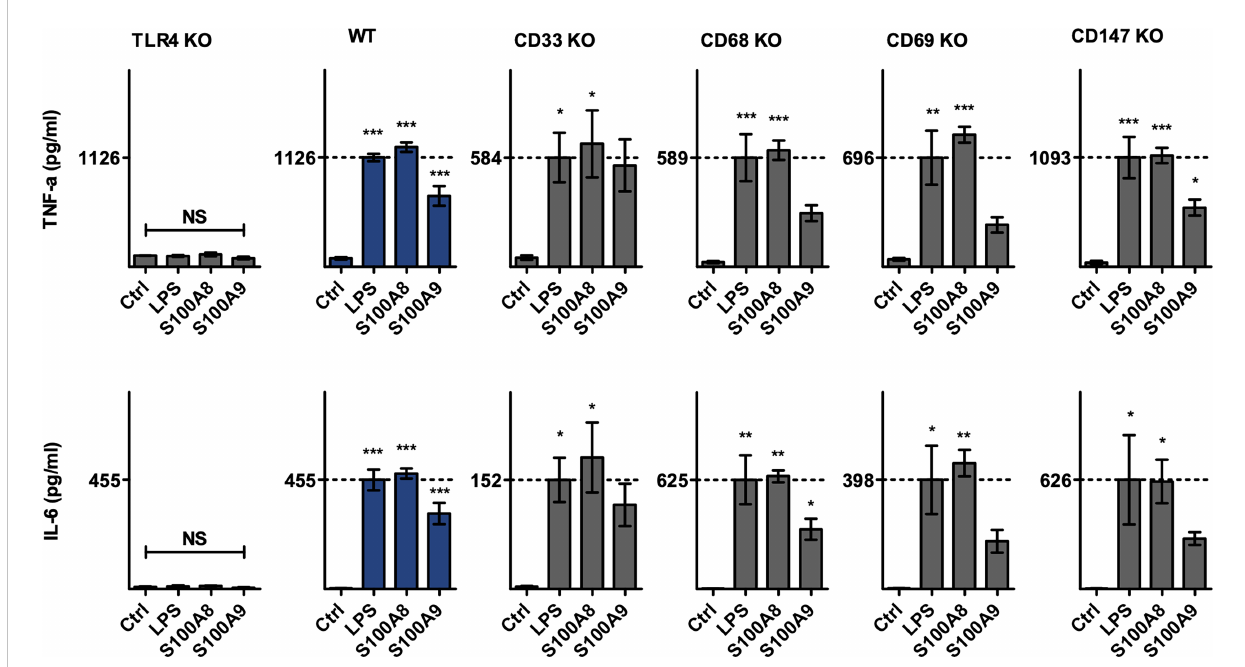
FIGURE 3 TNF- a and IL-6 upregulation upon S100A8 and S100A9 stimulation. CD33, CD68, CD69, CD147 and TLR4 knockout ER-Hoxb8 precursor cells, as well as WT ER-Hoxb8 precursor cells were differentiated into macrophages and subsequently stimulated with LPS, S100A8 homodimer, S100A9 homodimer or incubated without stimulus (Ctrl). TNF- a and IL-6 protein levels in cell culture supernatants were quanti fi ed using LegendPlex ™ assay (n = 3). Concentrations below the limit of quanti fi cation were set as LLOQ/2. Values are the means ± SEM. *p < 0.05, **p < 0.01, ***p < 0.001, NS = not signi fi cant, by one-way ANOVA and Dunnett's test in comparison to